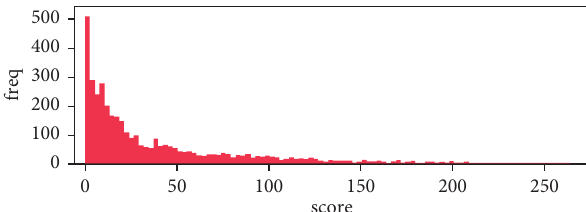
Figure 2: Histogram of frequency distribution of Sharp scores on the RA